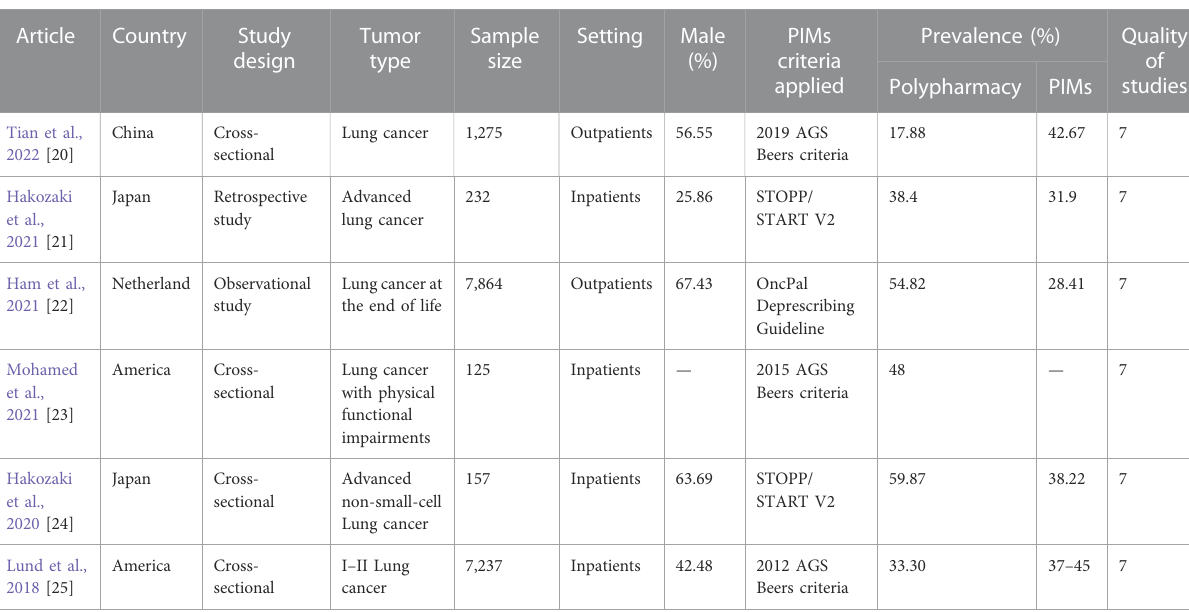
TABLE 1 Characteristics of included